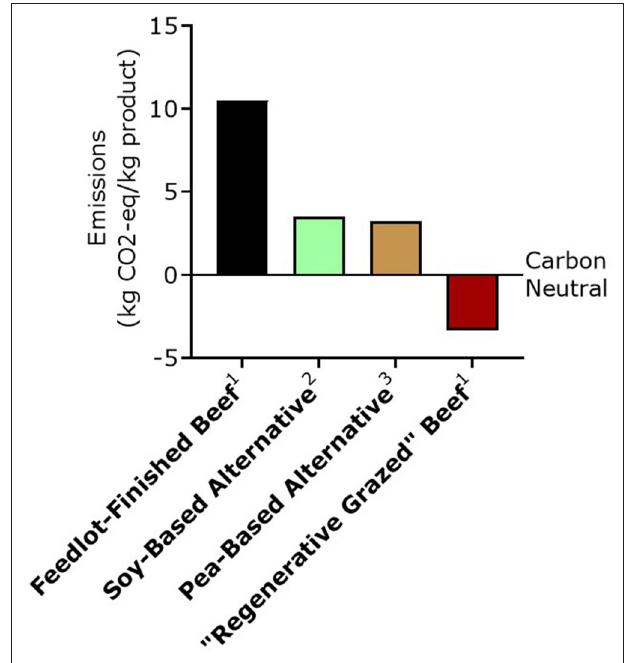
FIGURE 3 | Comparison of possible greenhouse gas emissions impacts of various beef production systems and meat alternatives. All values include cradle-to-distribution LCA, but excludes GHGE potential of retail, restaurant or at home use, and end-of-life stages. 1 From Stanley et al. (2018) assuming an edible yield of 60 and 55% carcass weight for feedlot-finished and “regenerative grazed” (adaptive multi-paddock grazed) beef, respectively with an addition of + 0.3 CO 2 -eq per kg product as published in Asem-Hiablie et al. (2019) to account for the lack of inclusion of GHGE potential of packing, which is taken into account in the LCA of the meat alternatives. 2 From Quantis International (2019b) . 3 From Heller and Keoleian (2018). CO 2 -eq,